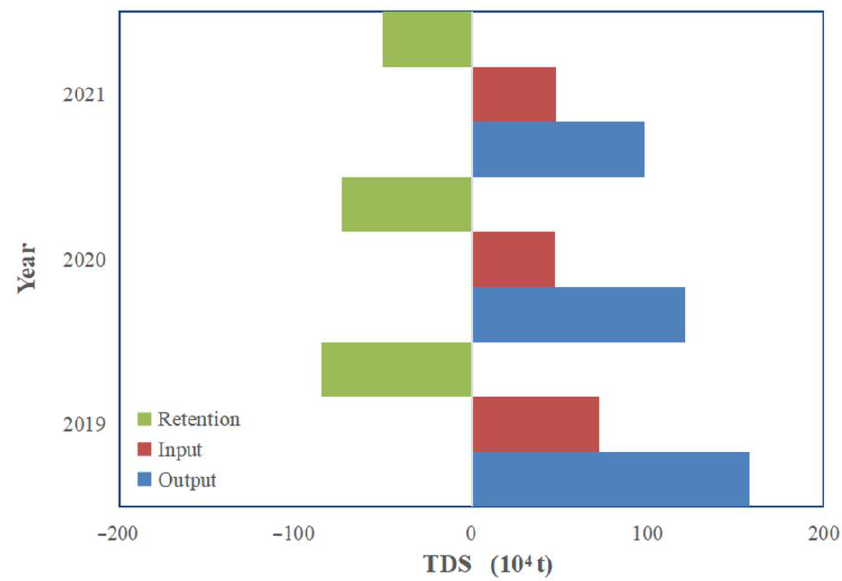
Figure 11. Butterfly chart of TDS amount entering the lake (Input), TDS amount discharged from the lake (Output), and TDS amount retained (Retention) in the lake in 2019 – 2021.